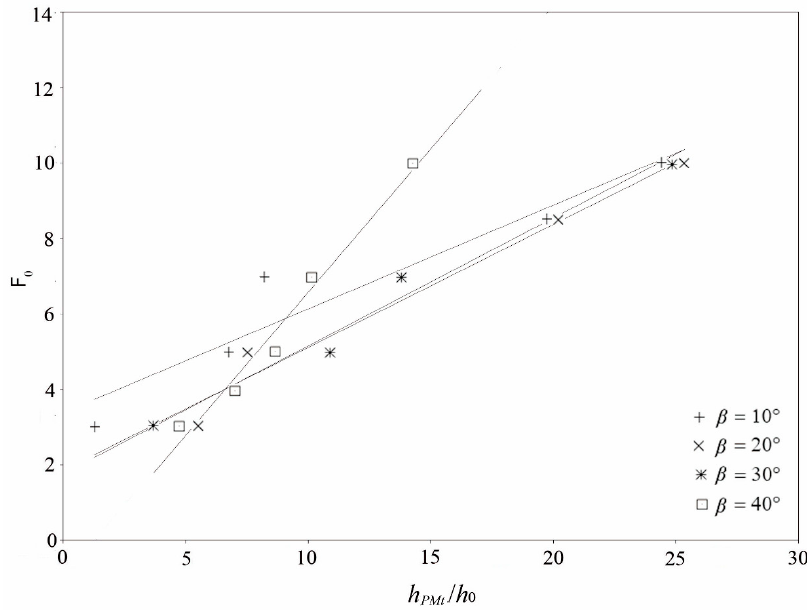
Figure 9. Correlations between the approach Froude numbers F 0 and the maxima dynamic pressure heads h PMt / h 0 acting on tailwater zone for the simulations with R = 0.10 m.